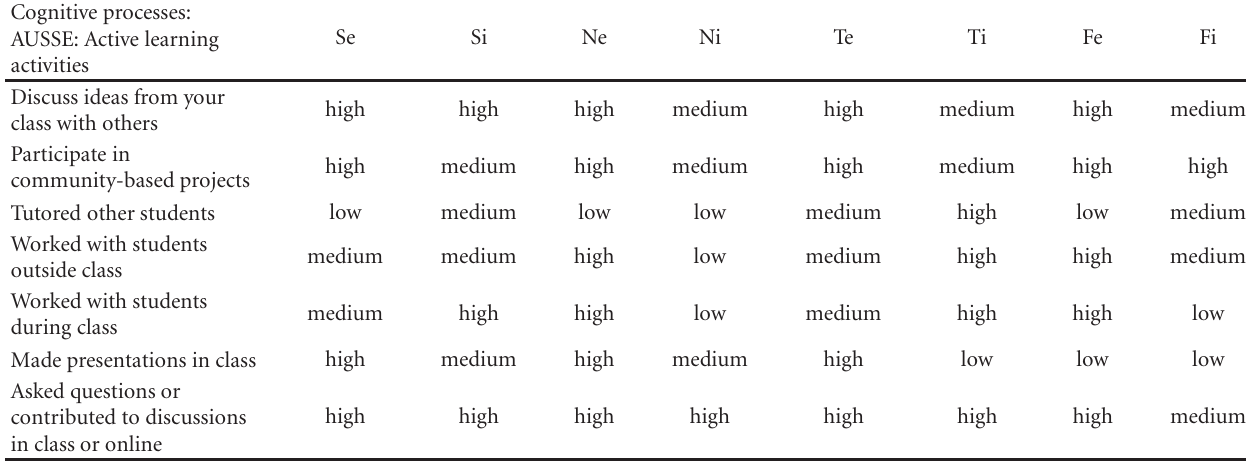
Table 1: Judgments by the panel of the likelihood of each cognitive process being apparent in each of the AUSSE learning activities related to student engagement.